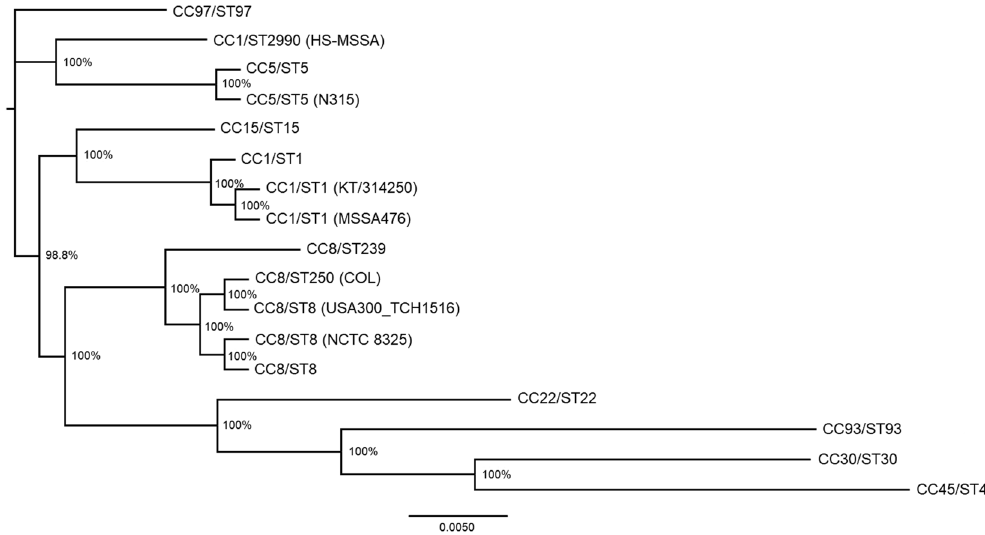
Figure 4. Phylogenomic tree inferred by maximum-likelihood method from SNP-based core genomes alignment of the S. aureus strains representing different multi-locus sequence typing (MLST) clonal complexes. The multiple genome sequence alignments of 17 S. aureus strains were generated by the online tool REALPHY using S. aureus NCTC 8325 as the reference genome. An unrooted phylogenomic tree was inferred by approximately Maximum Likelihood method using Generalized Time-Reversible (GTR) model with gamma distribution rates and 100 bootstrap replicates. Bootstrap support value is indicated as a percentage at each node. The representative genomes for each clonal complex are denoted as clonal complex/sequence type (i.e. CC1/ST1 represents MLST sequence type 1 in clonal complex 1). The PubMLST ID and European Nucleotide Archive (ENA) reference numbers of the representative genomes are available in Supplementary Table